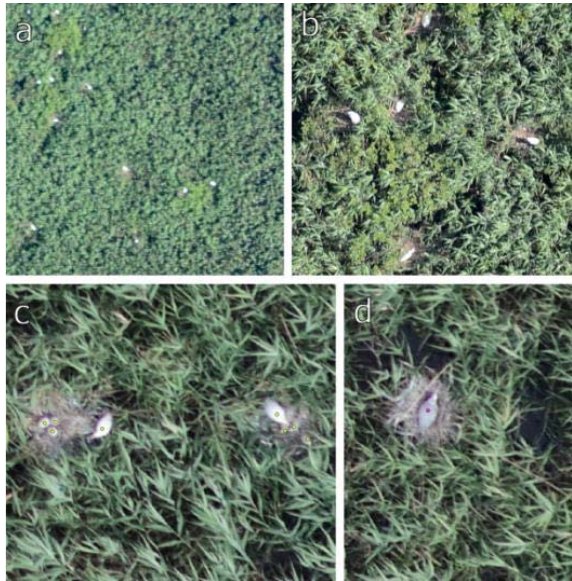
Figure 7. Comparison of the orthophotos with different spatial resolution. ( a ) Great White Egrets in the details of a medium (7.5 cm GSD) and ( b ) a high resolution (1.5 cm spatial resolution) orthophoto mosaic. ( c ) Great White Egrets and ( d ) a Grey Heron in its nest in the details of an orthophoto with 0.7 cm spatial resolution. GSD, ground sampling distance.